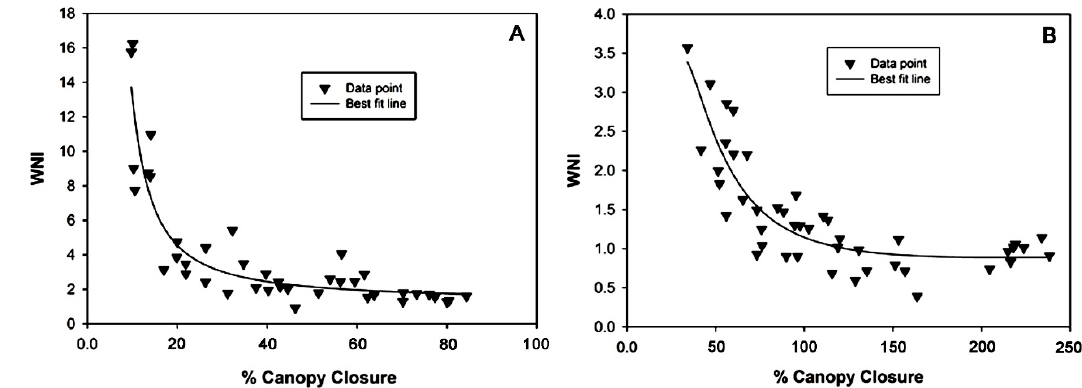
Figure 3. Inverse polynomial relationship between % Canopy Closure (CC) and the water need index (WNI) for Calathea ‘Silhouette’ ( A ) and Stromanthe sanguinea ( B ). Data points are four plant replicates, and the equation for the best fit line present in Table 2.